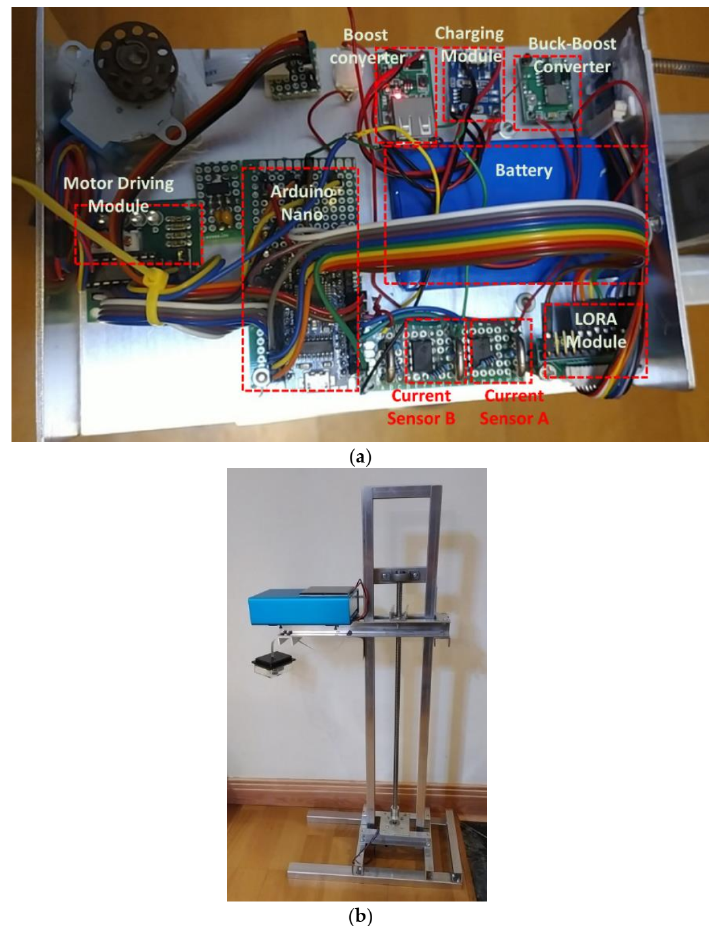
Figure 9. Realized water level monitoring system: ( a ) system structure, and ( b ) system